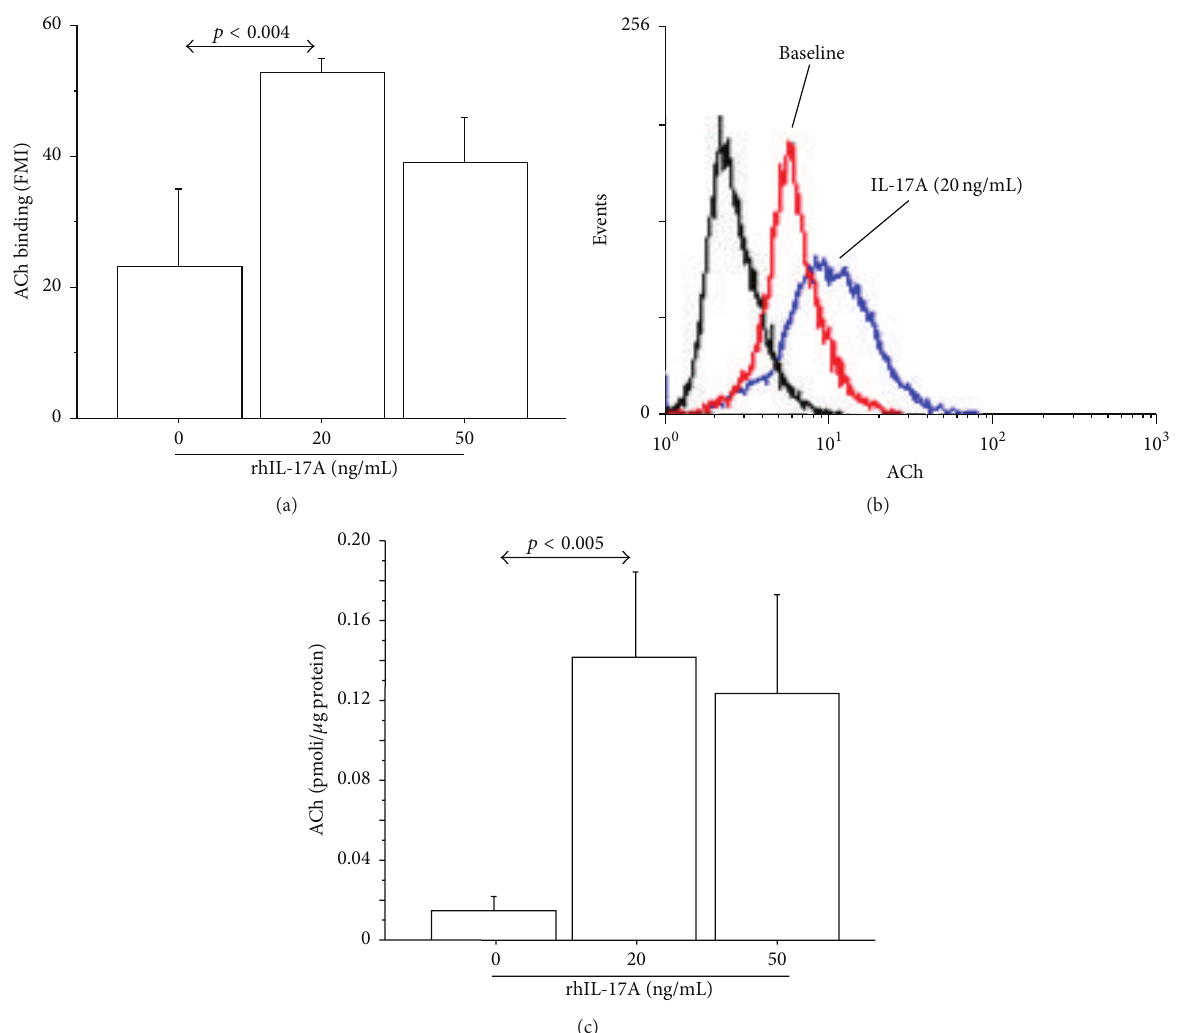
Figure 2: rhIL-17A increased endogenous ACh binding and production in 16-HBE cells. Cells were stimulated with rhIL-17A (0–50ng/mL) for 24 h to evaluate (a) ACh binding by flow cytometry. Bars represent mean ± SD of fluorescence mean intensity (FMI) of three separate experiments. (b) Representative flow cytometry analysis is shown. (c) ACh production expressed as pmoli/ 𝜇 g protein. Bars represent mean ± SD of three different experiments. Statistical analysis was performed by ANOVA test followed by Fisher’s PLSD multiple comparison test. The black curve represents the anti-IgG isotype negative control